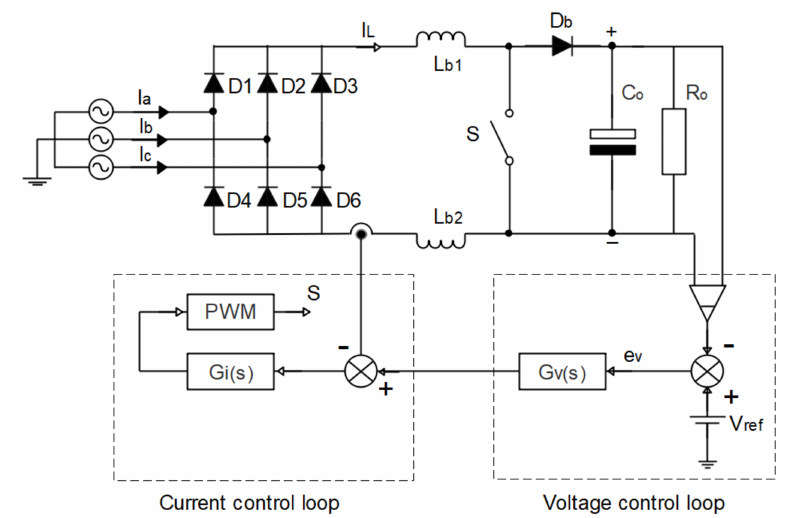
Figure 4. GRAETZ bridge rectifier with BOOST converter and respective control